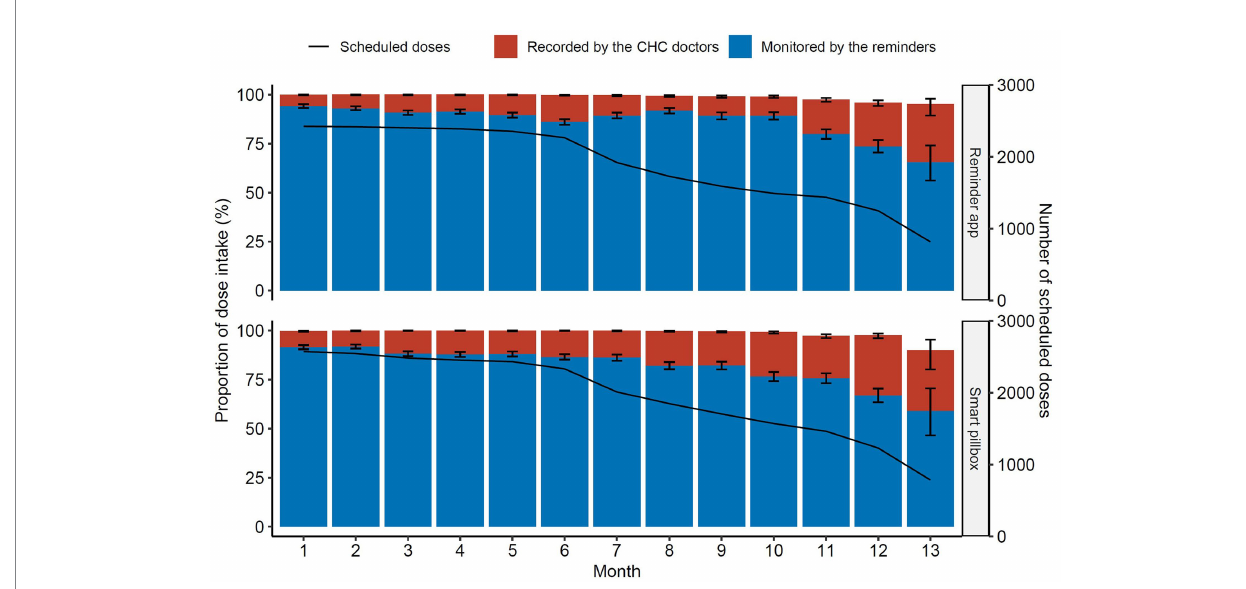
FIGURE 3 Proportions of dose intake through treatment. The black solid line indicated the monthly number of the scheduled doses. CHC, community health center.